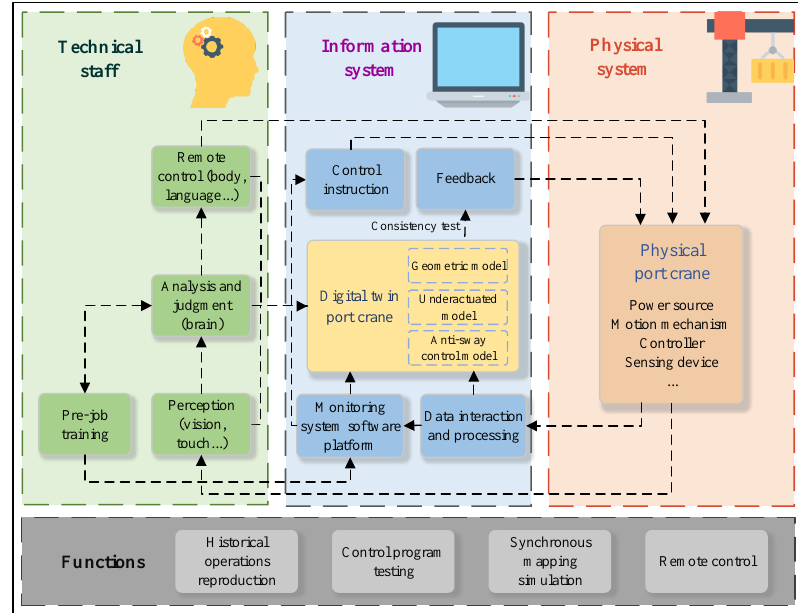
Figure 1. Framework of port crane monitoring system based on the digital twin.